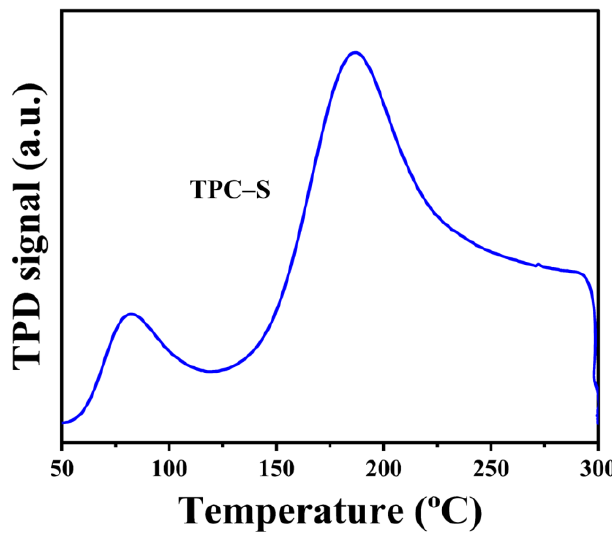
Figure 3. The NH 3 -TPD curves of TPC – S.